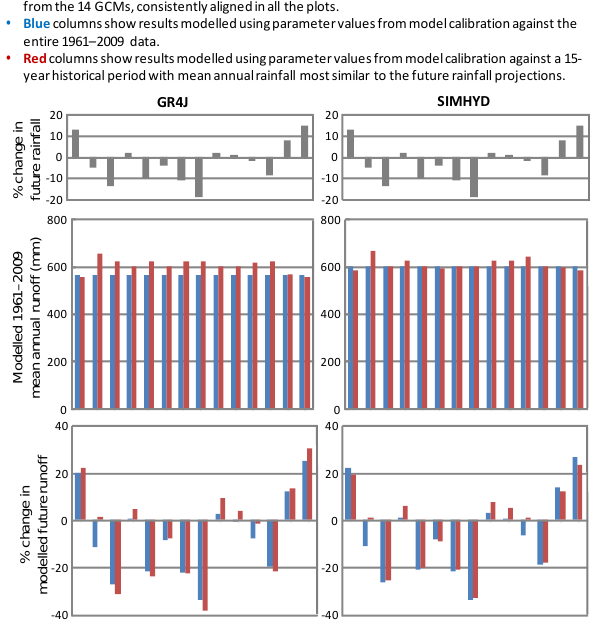
Figure 3. Modelling results for Catchment Figure 3 Modelling results for Catchment 405219